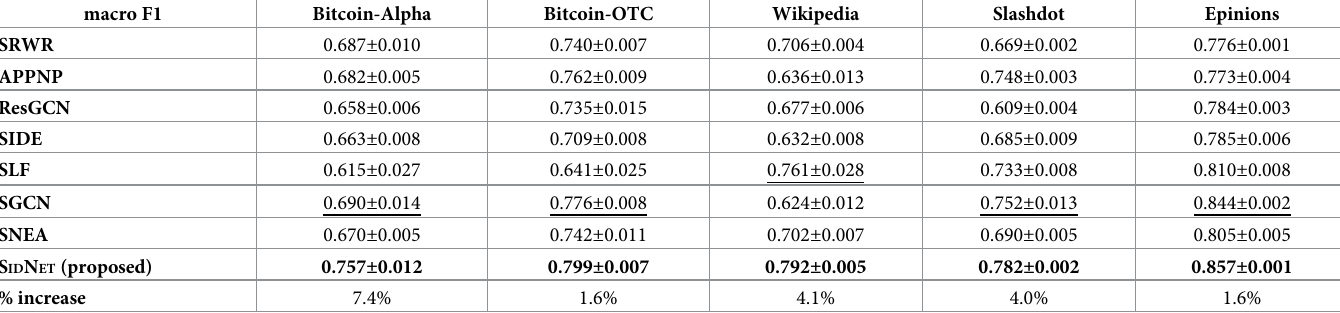
Table 4. S ID N ET gives the best link sign prediction performance in terms of macro F1. The best model is in bold, and the second best model is underlined. The % increase measures the best accuracy against the second best